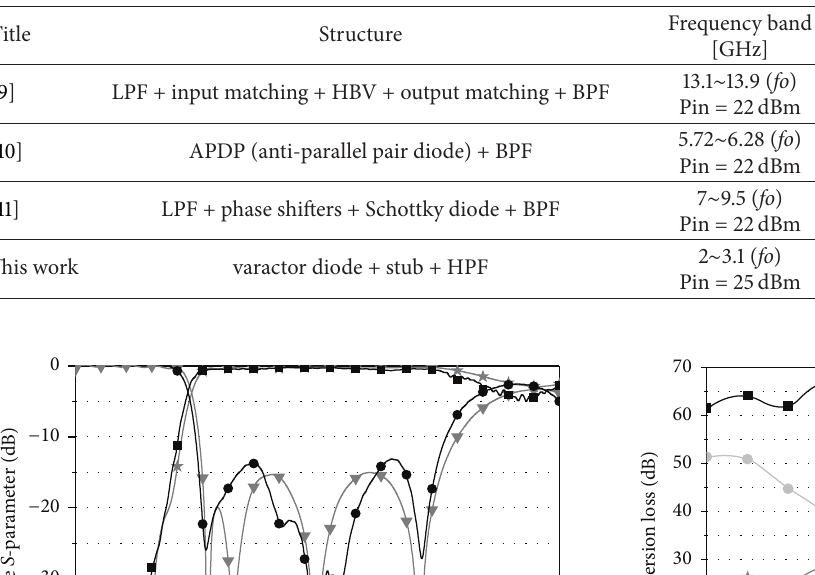
Table 1: A performance comparison of frequency tripler.